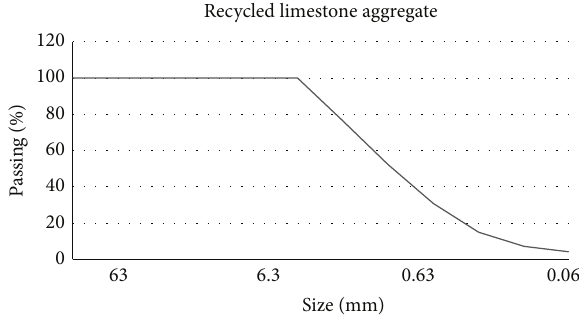
Figure 2: Limestone recycled aggregate gradation.